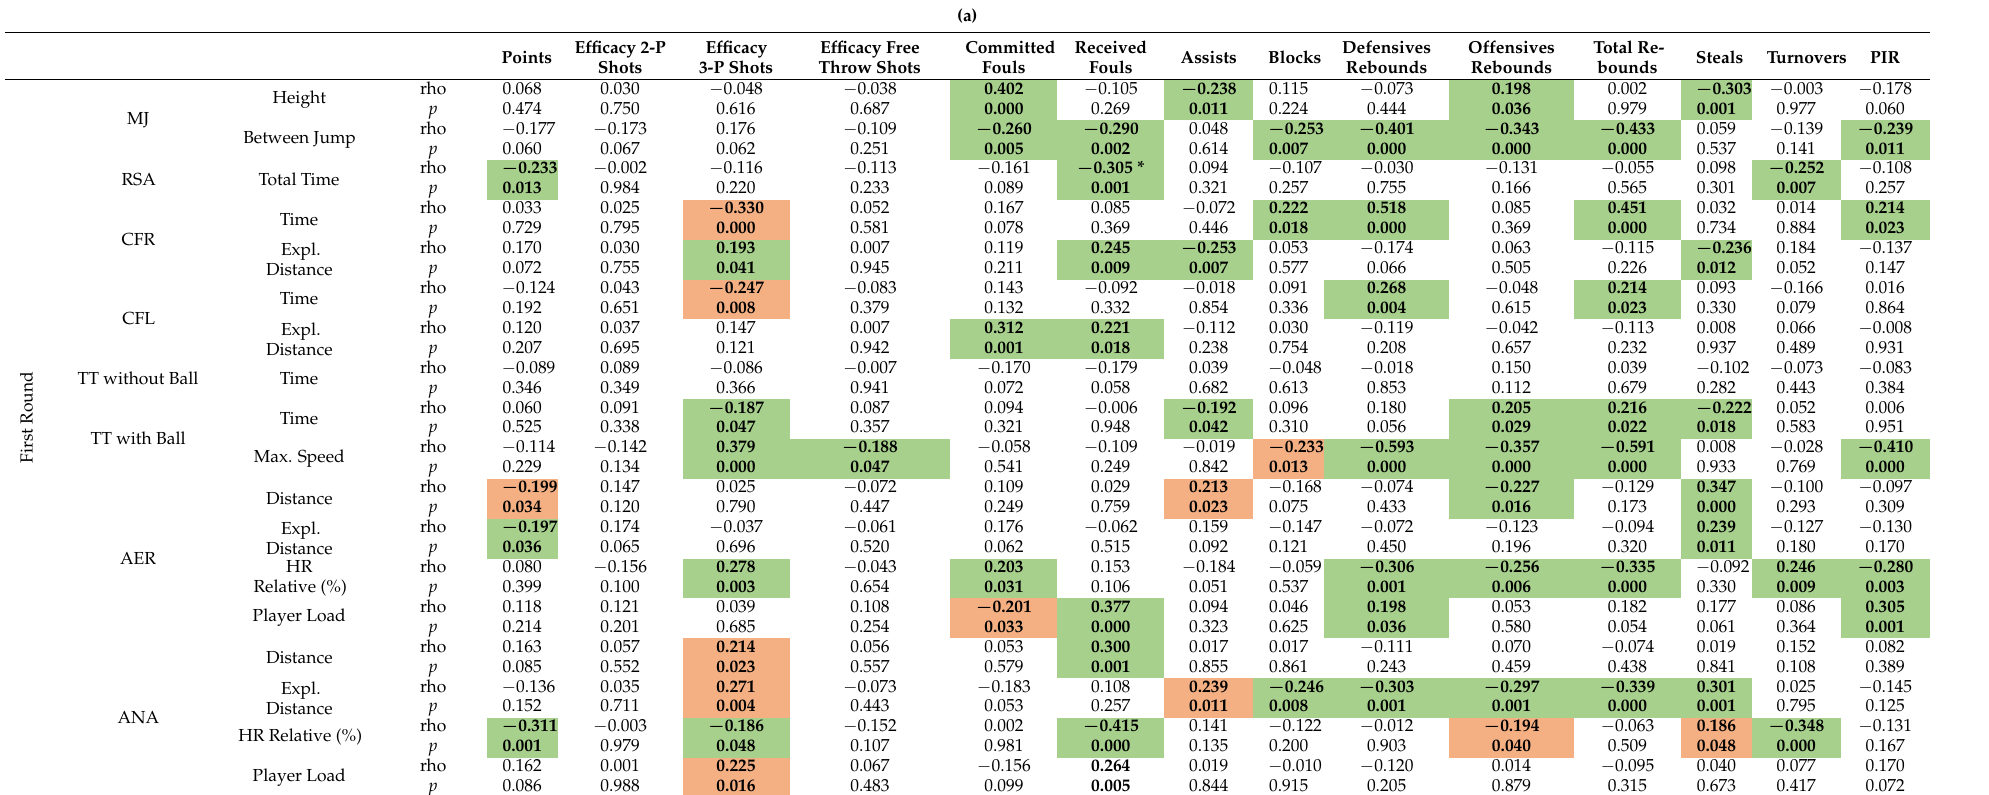
Table 5. ( a ) Results of the bivariate correlations between physical fitness and game indicators of the competition relativized per minute in the first round of the season. ( b ) Results of the bivariate correlations between physical fitness and game indicators of the competition relativized per minute in the second round of the